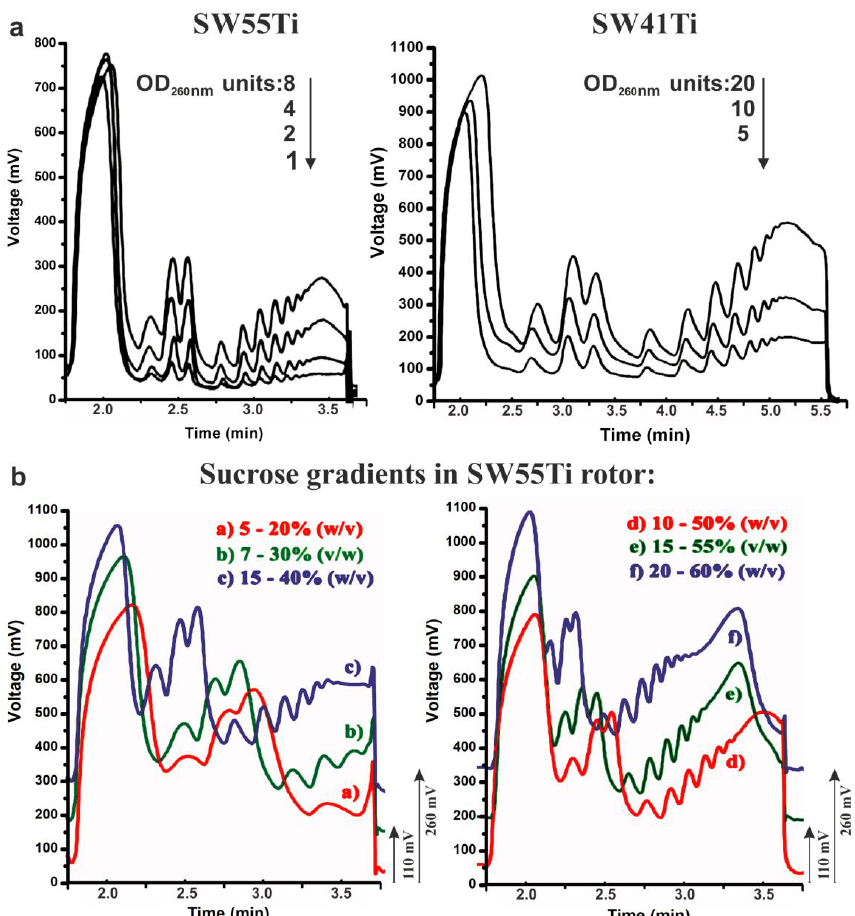
Figure 6. Sensitivity limit and versatility of polysome profiling in SW55Ti tubes. ( a ) 1–8 OD 260 nm of HEK-293 lysates were loaded onto 10%–50% sucrose gradients (in SW55Ti specific tubes) and centrifuged at 45,000 RPM for 65 min at 4 °C (left). Peak readability was compared to the one of conventional polysome profiles made in SW41Ti tubes, where 5–20 OD 260 nm were loaded onto 10%–50% gradients which were centrifuged at 35,000 RPM for 3 h at 4 °C (right). ( b ) Sucrose gradients of varying sucrose concentration ranges were prepared in SW55Ti tubes (a–f). Profiles in b + e and c + f were shifted up by 110 and 200 mV, respectively, to prevent overlapping of curve traces (to aid interpretation).